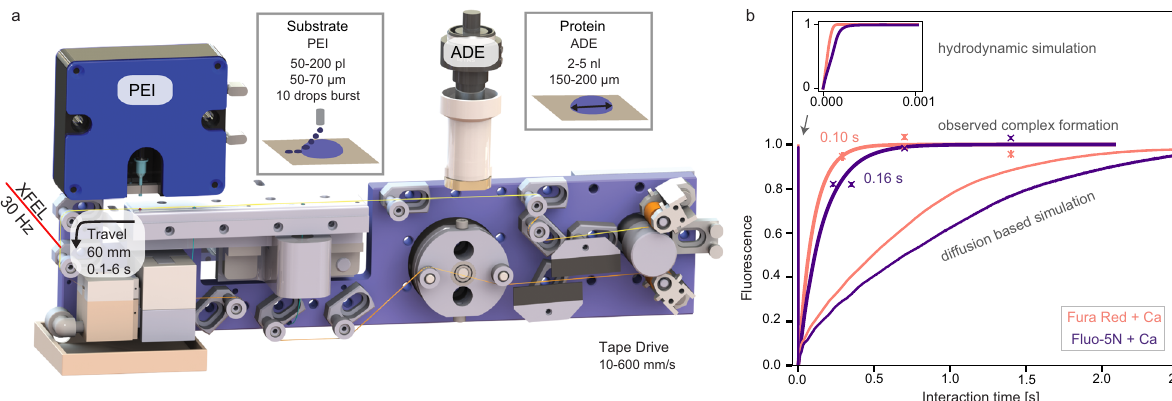
Fig. 1 Drop-on-drop experimental setup enables accelerated mixing in droplets. a Overview of the setup. The protein crystals are ejected by an acoustic droplet ejector (ADE, white and dark gray column above tape and on the right-hand side) and synchronized to the XFEL master clock. The burst of substrate drops is ejected by a piezoelectric injector (PEI, blue box above tape, on the left-hand side) that can accommodate disposable cartridges with a range of ori fi ces that dictate the size of the droplets. Reaction time is varied by the speed of the tape drive (10 – 600 mm s − 1 ) and depends upon the location of the PEI with respect to the ADE droplet intersection and the X-ray interaction points; in the case reported here, we selected time points between 0.1 and 6 s. b Relative fl uorescence intensity (crosses) of the calcium-bound forms of Fura Red (salmon) and Fluo-5N (purple) dyes obtained from the scaling of the normalized spectral components and their errors of the fi ts (Supplementary Fig. 5) compared to reaction simulations of collision-driven hydrodynamic fl ow (inset) and equilibration by diffusion. Lines correspond to the fi tted exponential functions of the experimental data and rise times are indicated. Fluorescence signal of Fura Red rises faster than Fluo-5N due to the lower dissociation